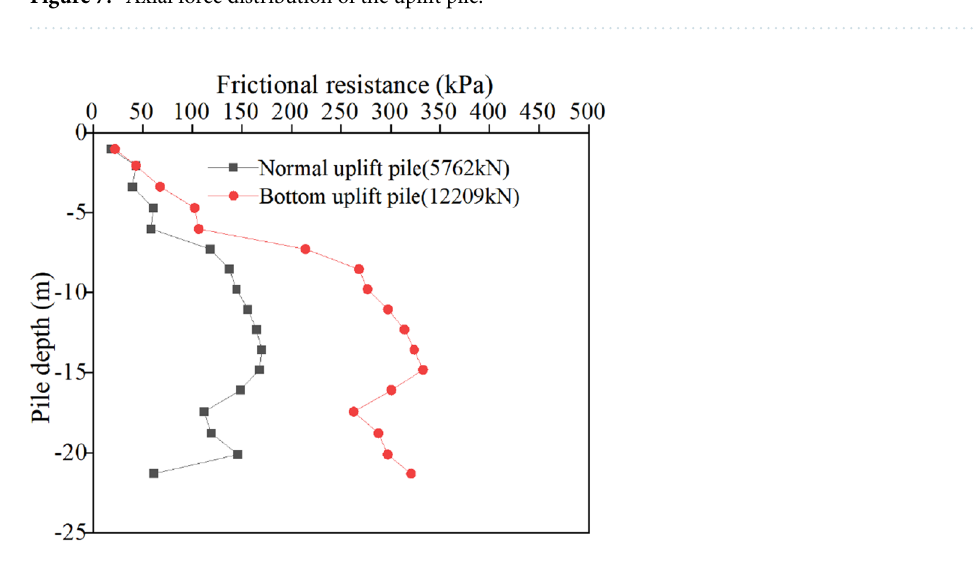
Figure 8. Ultimate frictional resistance of the uplift